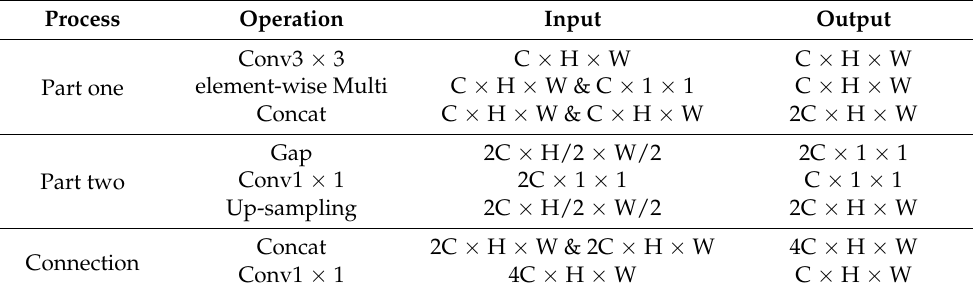
Table 1. Operation of FFB